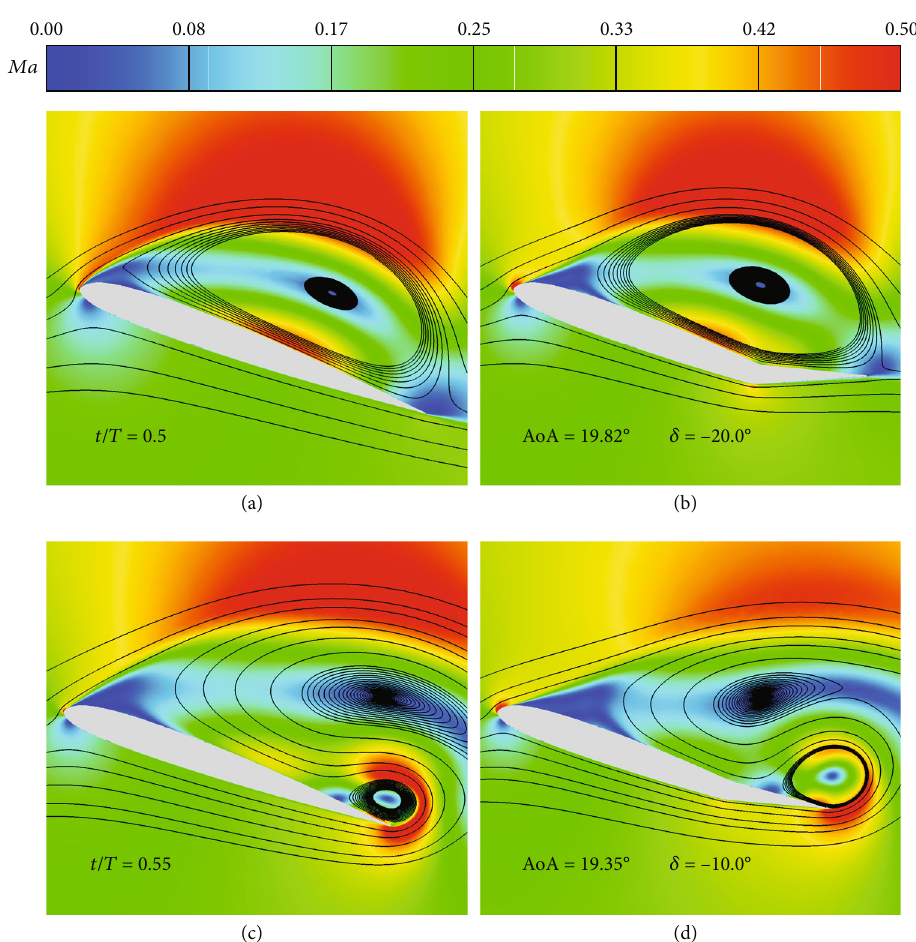
Figure 20: Streamlines and Mach number contours at di ff erent angles of attack for the two airfoils: (a, c) original airfoil and (b, d) TEF airfoil.